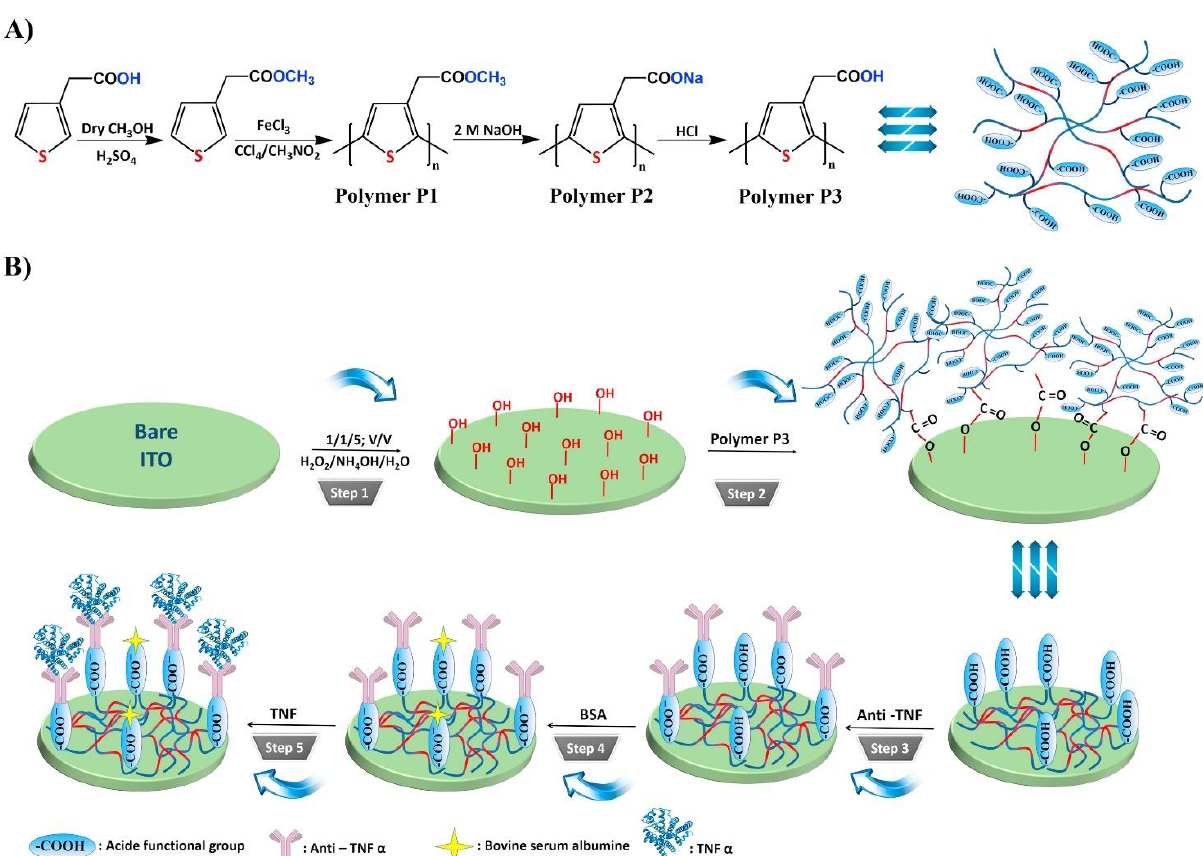
Figure 10. Schematic illustration depicting the bio-functionalization steps of a ITO/P3/TNFα biosensor. ( A ) Process for generating P3 polymer. ( B ) Ab is immobilized on the ITO electrode via P3 linker, which captures TNFα. Reprinted from [96] with permission from Elsevier.